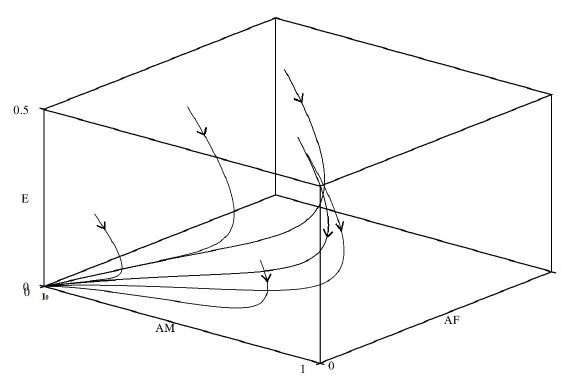
Fig. 6. Solutions of system (4) with ˆ f = 0 . 01 and K =